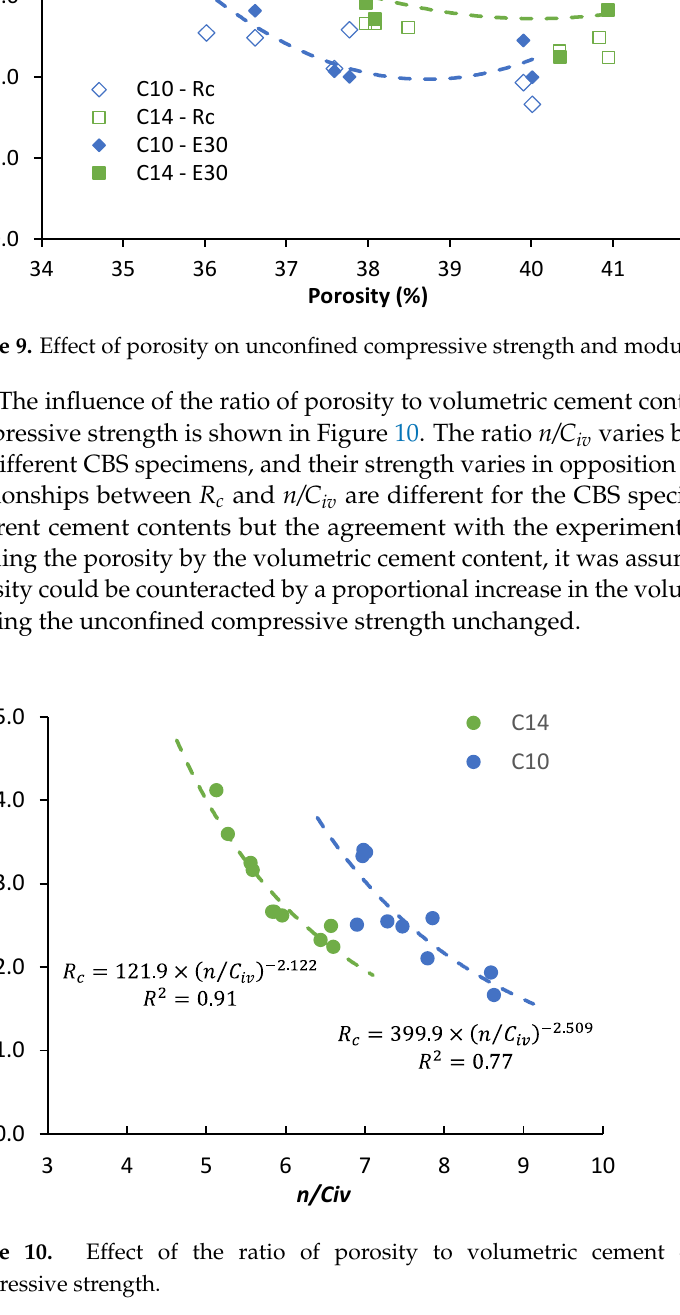
Figure 10. Effect of the ratio of porosity to volumetric cement content on unconfined compressive strength.